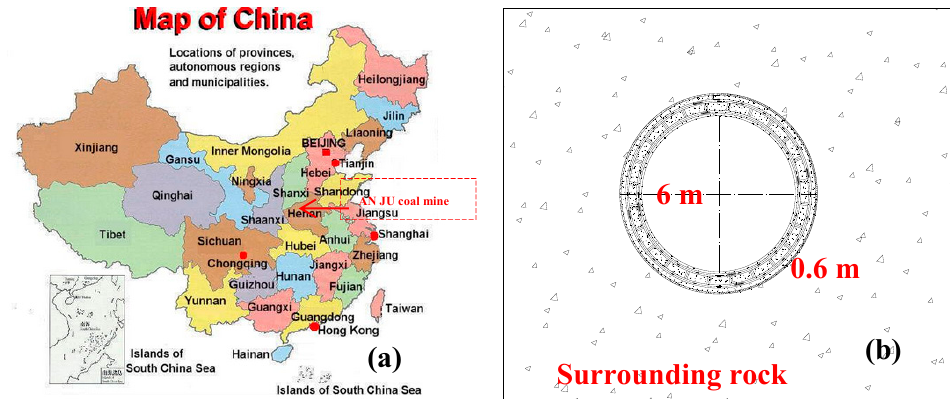
Surrounding rock Figure 2. ( a ) The location of the An JU coal mine. ( b ) Plan view of the Figure 2. ( a ) The location of the An JU coal mine. ( b ) Plan view of the shaft.